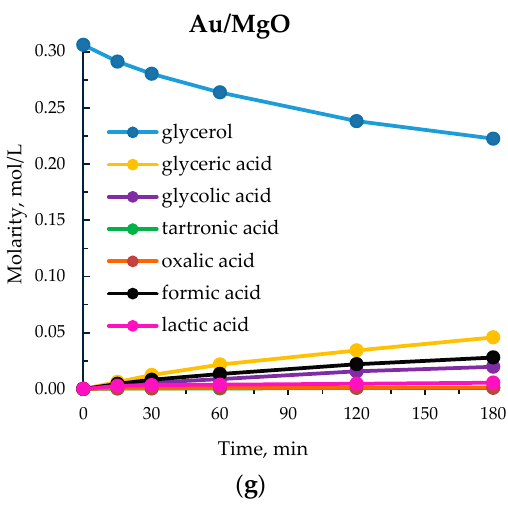
Figure 2. Product distribution in glycerol oxidation on gold supported catalysts ( a – g ). Reaction conditions: T = 50 °C, NaOH/glycerol = 4 eqv., R = 1000, 1100 rpm of stirring rate.